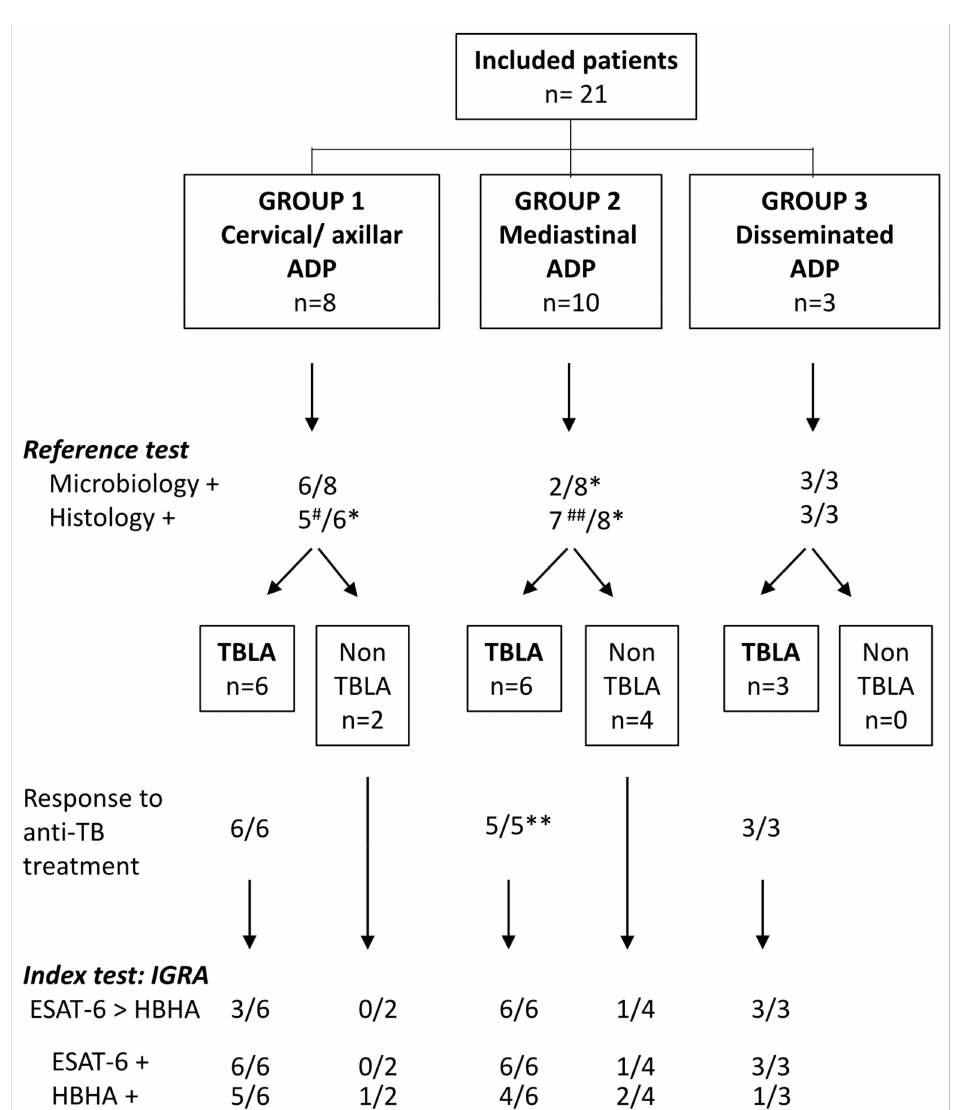
Figure 1. Flow chart comparing the index test to the reference test for the diagnosis of TBLA. Final diagnosis of TBLA among the 21 included patients was based on the reference test, the M. tuberculosis culture, and PCR performed on biopsies (summarized as microbiology in the figure), and in case of negativity, on results from histological analysis who were considered as helpful, albeit often not specific. Histology was considered as positive when necrotic granuloma was noticed and doubtful in the case of epitheloïd granuloma, granuloma without necrosis, or necrosis without granuloma. Diagnosis was confirmed by clinical and radiological responses to treatment. The index test was the combined HBHA/ESAT-6 IGRA and more precisely a higher IFN- γ response to ESAT-6 than to HBHA. # : doubtful for 3 patients; ## : doubtful for 5 patients; *: not available for 2 patients; **: not available for 1